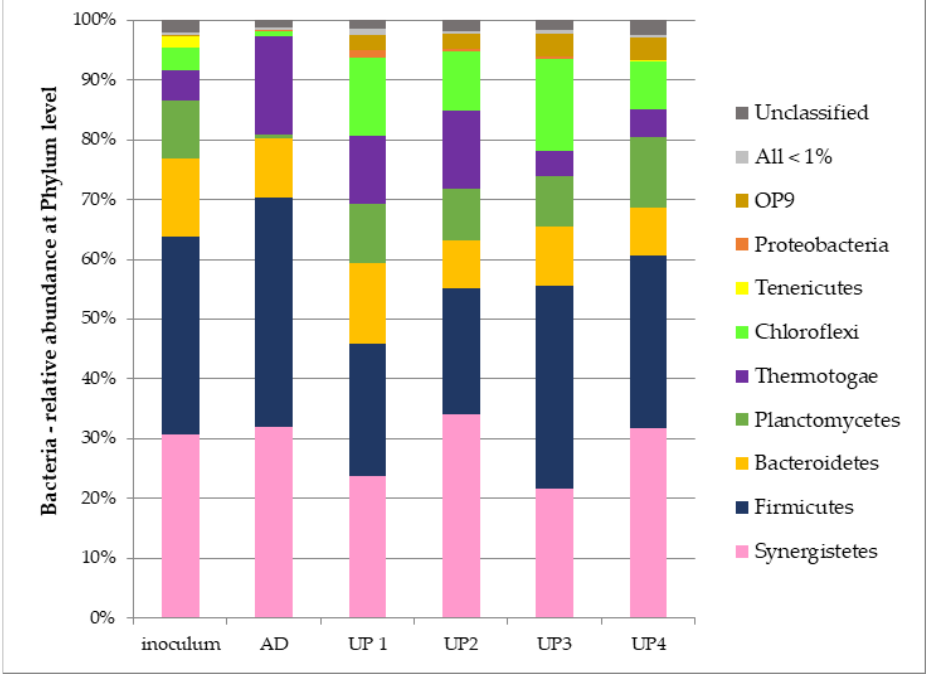
Figure 3. Relative abundances of the bacteria community at phylum level in the sludge used as inoculum, at the end of AD and UP1 and UP4 phases. Communities with a relative abundance ≥ 1% in at least one sample are reported.